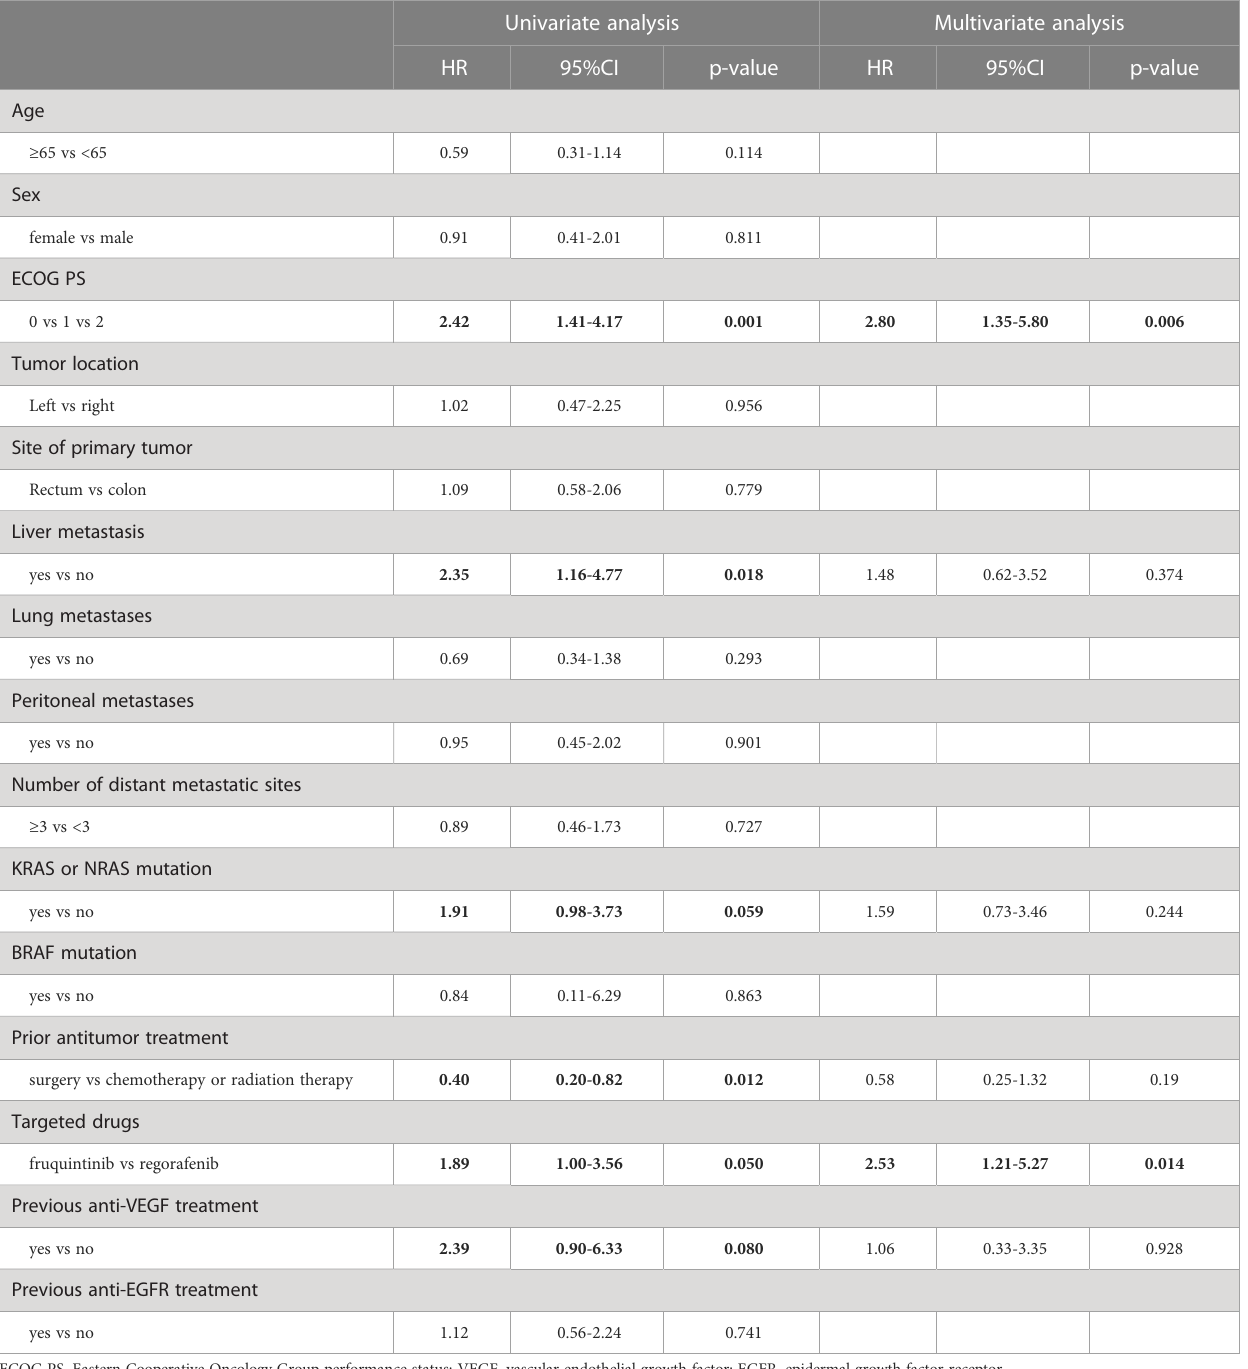
TABLE 5 Univariate and multivariate analyses of risk factors for OS of FP and RP.